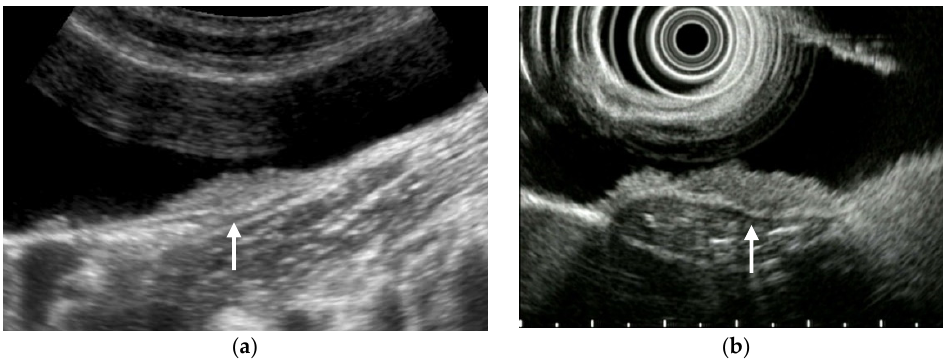
Figure 13. Discontinuity of an outer hyperechoic layer. A high-frequency transducer showed the discontinuity of an outer hyperechoic layer (arrow) in focal GWT ( a ), EUS also delineated the thinning of an outer hyperechoic layer (arrow) ( b ) (GBC case).